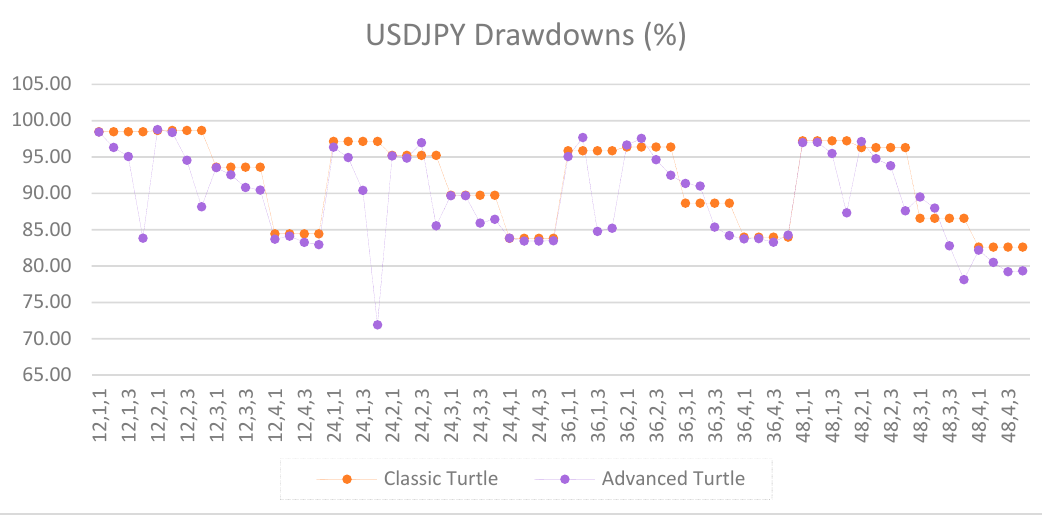
Figure A10. Drawdowns of USDJPY as percentage of equity between the classic and the advanced Turtle systems for every combination of N, X, Y for the fast parameters (20, 40).